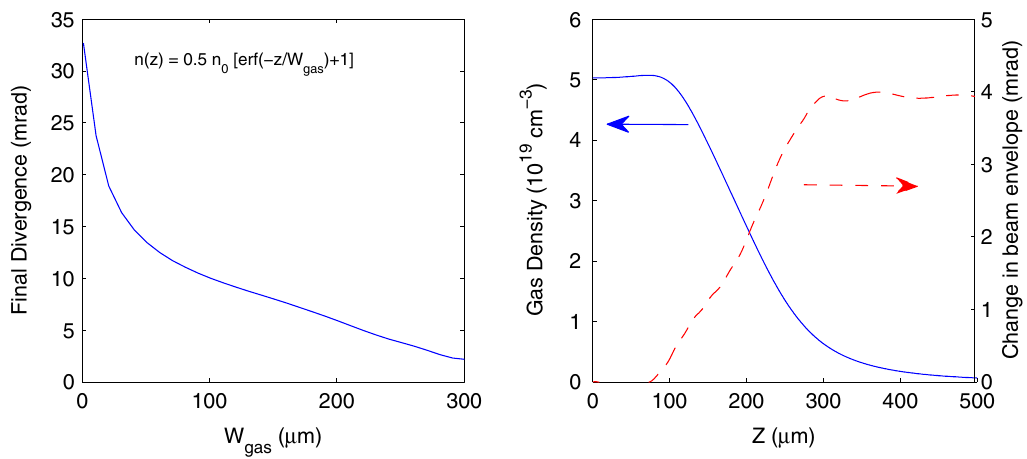
FIG. 5. Left: Outcoupled LWFA beam divergence as a function of downstream plasma density taper starting from n 0 ¼ 3 (cid:5) 10 19 cm (cid:1) 3 . Right: Evolution of the beam envelope derivative inside the plasma along the plasma profile of the nozzle used in the experiment. The derivative of the envelope settles to a final divergence of 4 mrad rms.